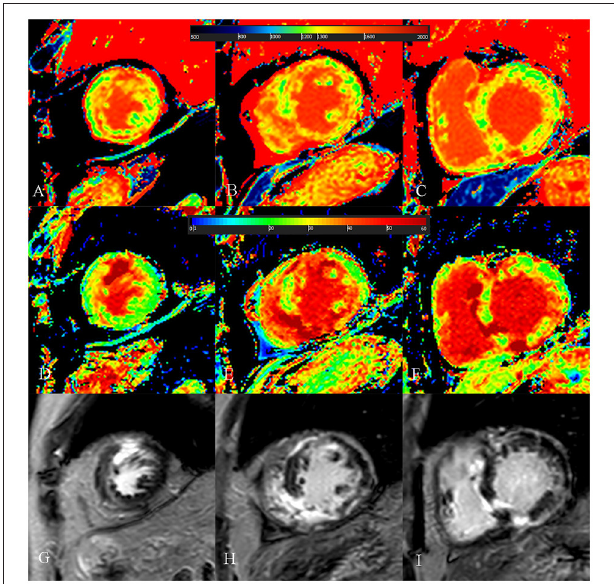
FIGURE 6 | A 52-year-old male with burned out phase hypertrophic cardiomyopathy. (A – C) Native T1 mapping of the apical, mid-, and basal portions of the left ventricular (LV) myocardium revealed higher global native T1 (1,380.7ms). (D – F) Extracellular volume fraction (ECV) of the apical, mid-, and basal portions of the LV myocardium showed higher global ECV (32.8%). (G – I) Late gadolinium enhancement (LGE) images of the apical, mid-, and basal portions of the LV myocardium showed multiple LGE. The maximal LV wall thickness was 13mm, left atrial diameter was 53mm, and the LV outflow tract gradient pressure was 2 mmHg. He had non-sustained ventricular tachycardia, but no family history of sudden cardiac death (SCD), and unexplained syncope. He had LGE/LV mass ≥ 15% (elevated LGE/LV mass: 56.2%) and end-stage systolic dysfunction but no apical aneurysm. He was stratified with low SCD risk under the 2014 European Society of Cardiology guidelines (5-year SCD probability: 3.39%) and high SCD risk under the enhanced American College of Cardiology/American Heart Association guidelines. He underwent cardiac transplantation 35 months after cardiac MRI examination. End-stage systolic dysfunction strongly indicated poor outcome in this patient. However, increased global native T1 mapping and ECV values could also suggest that the patient was likely to be at high risk of SCD and needs further